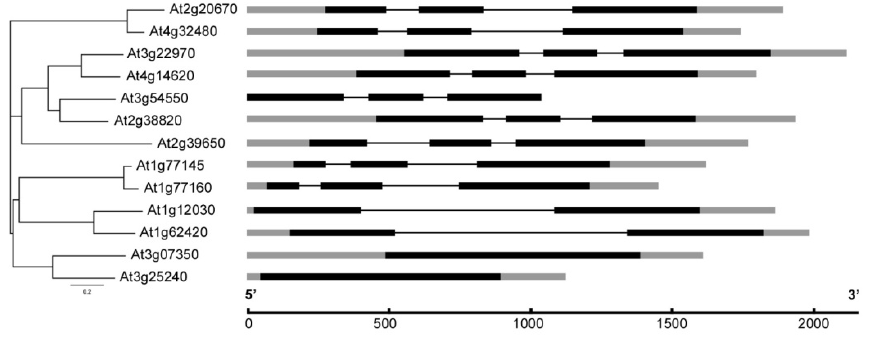
Figure 3. Phylogenetic analysis and exon-intron distribution of Arabidopsis DUF506 genes. Exon, intron and UTR are represented by black rectangle boxes, black lines and grey rectangle boxes, re- spectively.